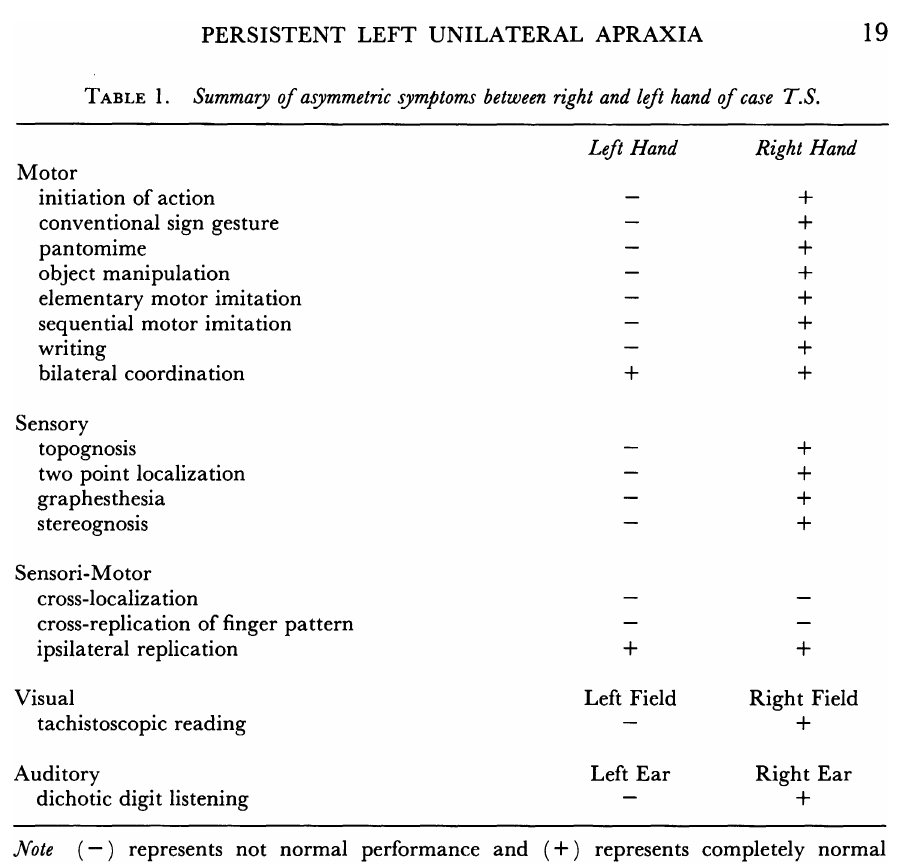
TABLE I. Summary oj asymmetric symptoms between right and left hand of case